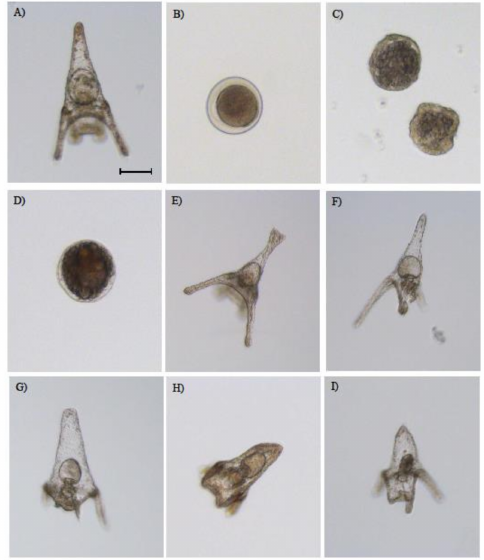
Figure 3. Examples of ( B ) fertilized eggs, ( C , D ) malformed blastulae, and ( E – I ) malformed plutei after exposure of fertilized eggs of P. lividus to PAHs and Cu, with respect to ( A ) the control, embryos deriving from fertilized eggs grown without PAHs and Cu. Scale bar = 50 µ m; Leica DMi6000 B inverted